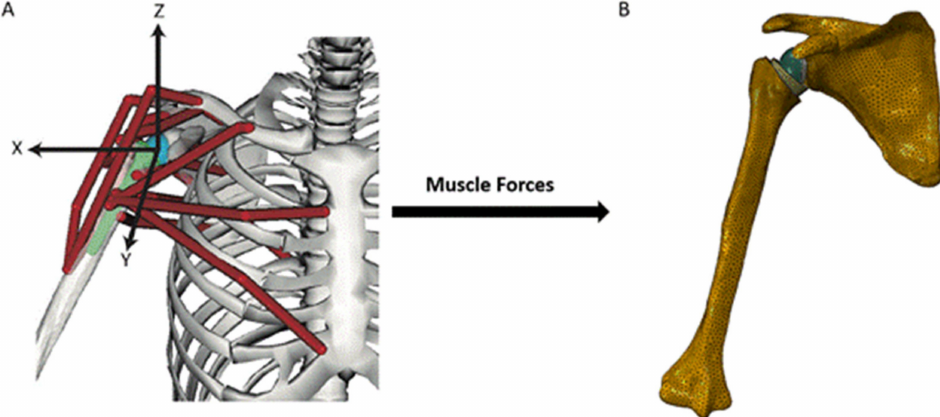
Figure 1. A multi-body modeling framework used to investigate joint stability after RTSA [28], including a rigid body model to simulate muscle and joint loading at the shoulder ( A ), and a FE model to calculate internal stresses and strains at the bone and implant ( B ). The muscle and joint forces calculated from the rigid body model were input into the finite element model and used to drive simulations of joint loading during activities of daily